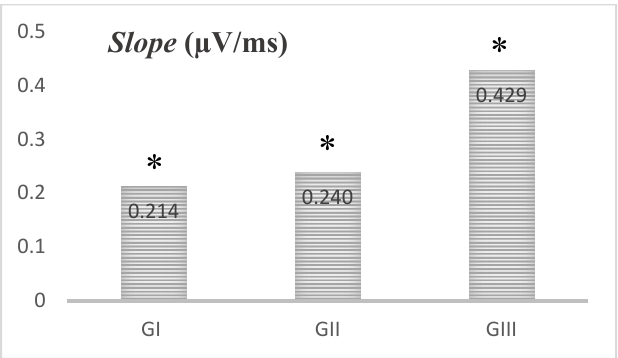
Figure 2. Slope of the VA complex extracted from the Frequency Following Response assessment in the three groups surveyed ( n = 80). Statistical test: Kruskal–Wallis; * indicates a statistically significant difference between GI and GIII ( p ≤ 0.001 *) and between GI and GII ( p ≤ 0.001 *).